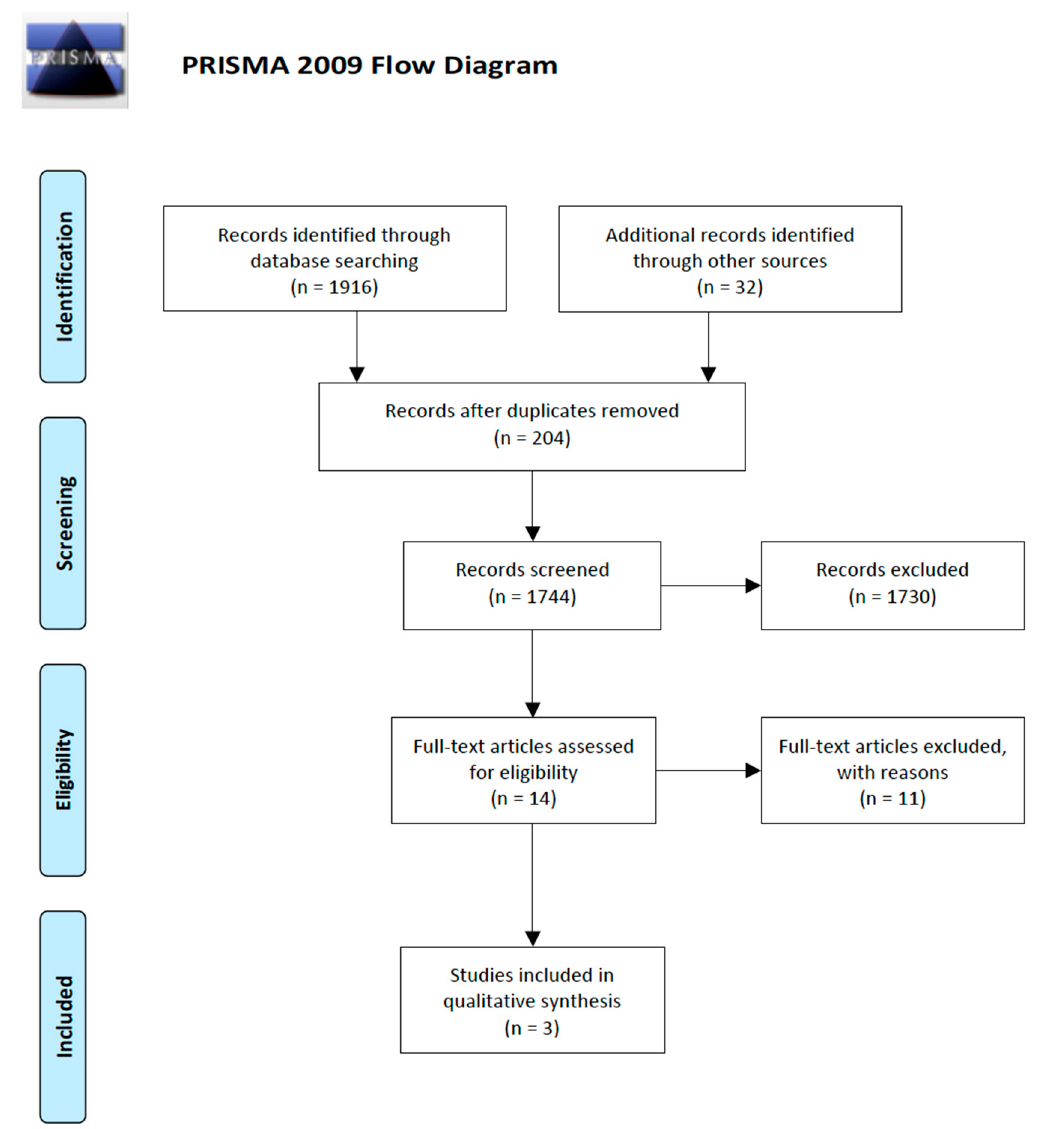
Figure 1. Flow chart of the screening process.